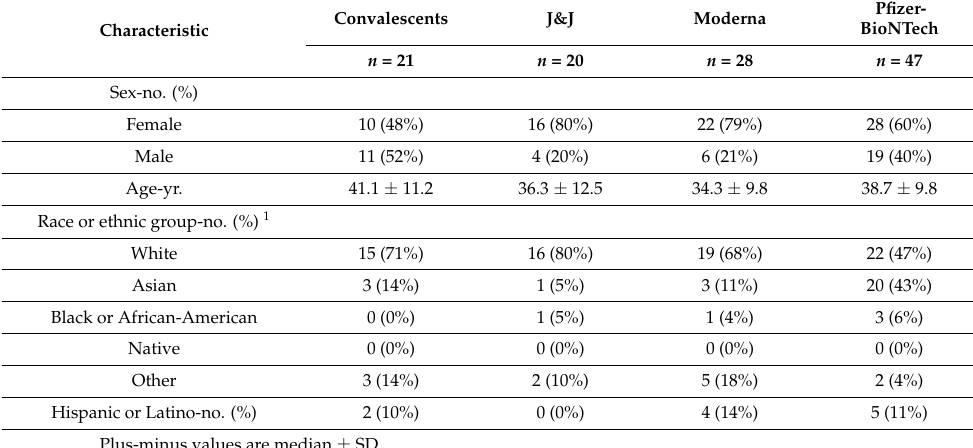
Table 1. Demographic Characteristics of the Participants in the